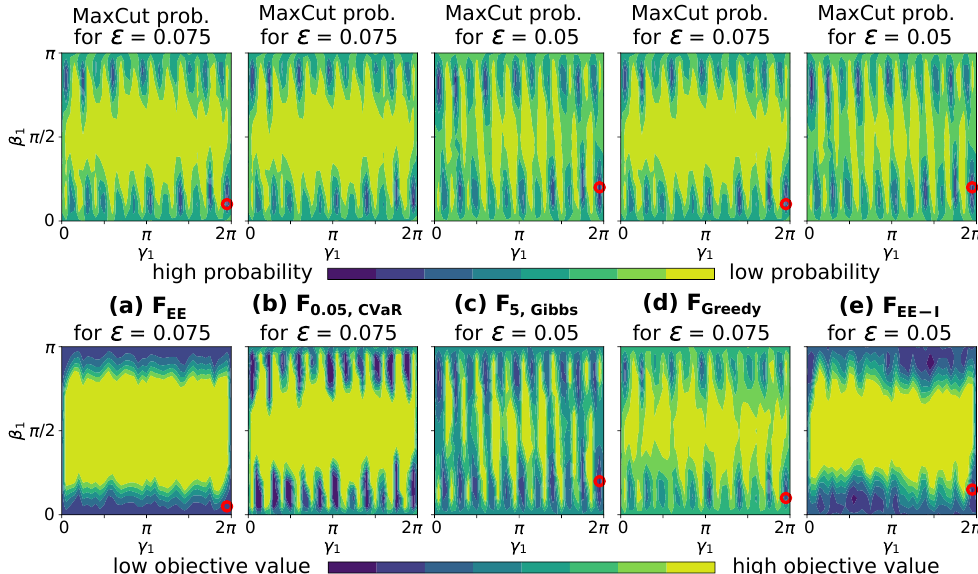
Figure 8. Grid search in the ( γ 1 , β 1 ) space for depth-1 WS-QAOA on G 12, fc with initial cut of size 92 (cf. Table 1) using different objective functions (lower half) compared to MaxCut probability (upper half). The distance between the evaluated points is π /20. α and η for F α , CVaR , F η , Gibbs were set to exemplary values. For F EE , F 0.05, CVaR , F 5, Gibbs , and F EE-I , only values below manually set thresholds were plotted to increase contrast and emphasize minima. Red circles mark the highest MaxCut probabilities and lowest objective values